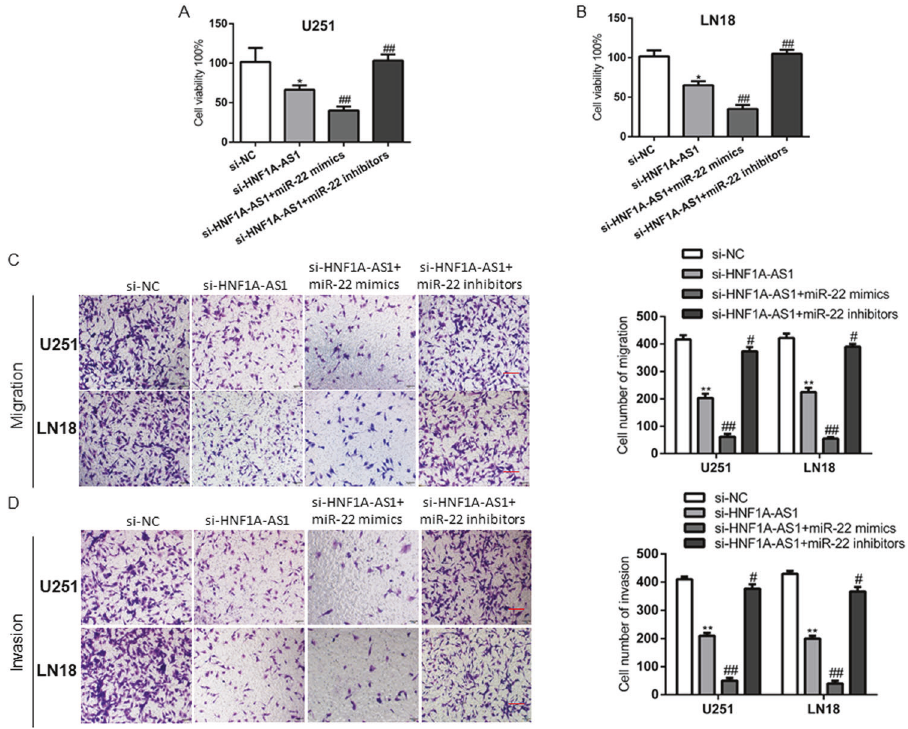
Fig. 7 MiR-22 inhibition reversed the si-HNF1A-AS1 induced inhibitory effects on GBM cells. A , B CCK-8 assay was performed to determine the proliferation after co-transfected with si-HNF1A-AS1 and miR-22 mimics or miR-22 inhibitors. * P < 0.05 vs. si-NC group; ## P < 0.01 vs. si- HNF1A-AS1 group. C , D Transwell assay in U251 and LN18 cells was performed to determined cell migration and invasion ability after co- transfected with si-HNF1A-AS1 and miR-22 mimics or miR-22 inhibitors (scale bar: 200 μ m). ** P < 0.01 vs. si-NC group; # P < 0.05, ## P < 0.01 vs. si-HNF1A-AS1 group. Data are presented as mean ± SD from three independent